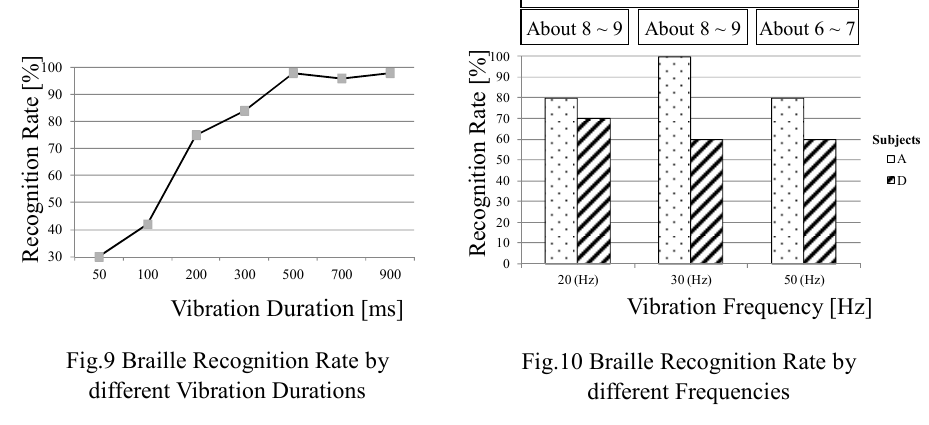
different Frequencies